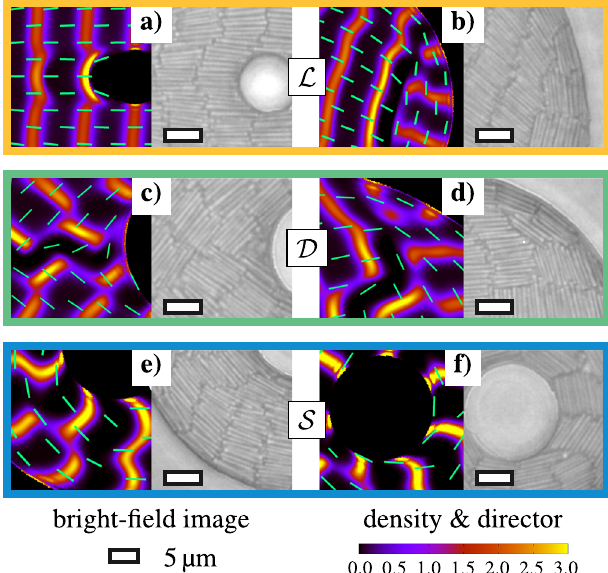
Fig. 4 Structural details on the particle scale. According observations from theory (left, density plots as in Fig. 1d) and experiment (right): a bent layers adjacent to the inclusion and b deformed layer near curved outer wall in the laminar state ( L ), and c gap between two domains close to the inclusion in the domain state ( D ) and d planar alignment of rods at the outer wall e deformed layers adjacent to an edge dislocation and f tilted alignment of some layers at the inclusion in the Shubnikov state ( S